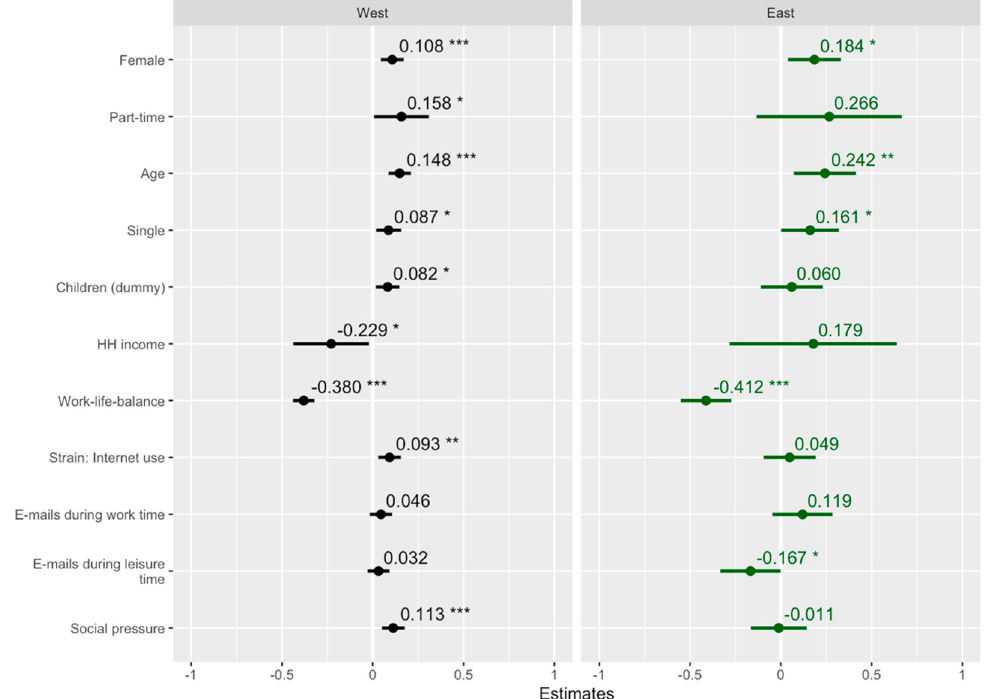
Figure 1. Predictors of exhaustion in East and West Germany. * p < 0.05, ** p < 0.01, *** p < 0.001. Standardized β coefficients, using two ordinary least squares regressions differed by region, are presented. East Germany: N = 169. West Germany: N = 896.